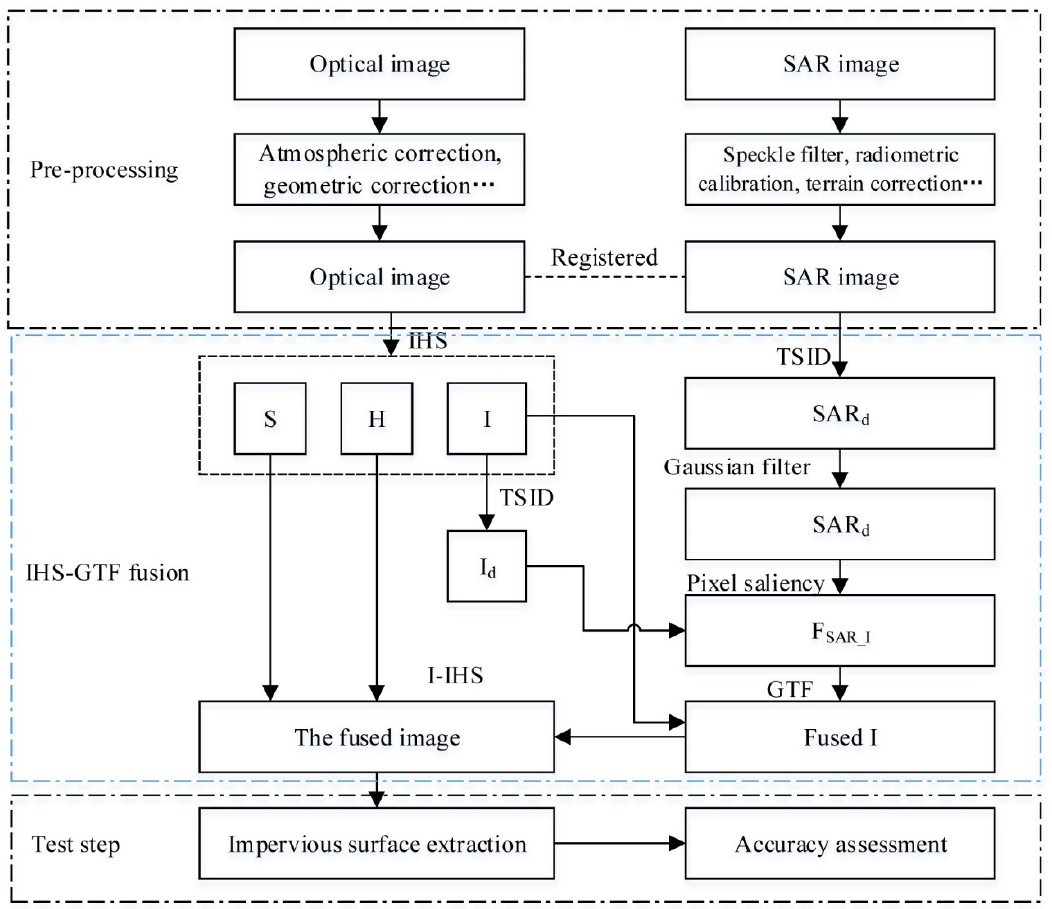
Figure 2. The framework of the proposed method .